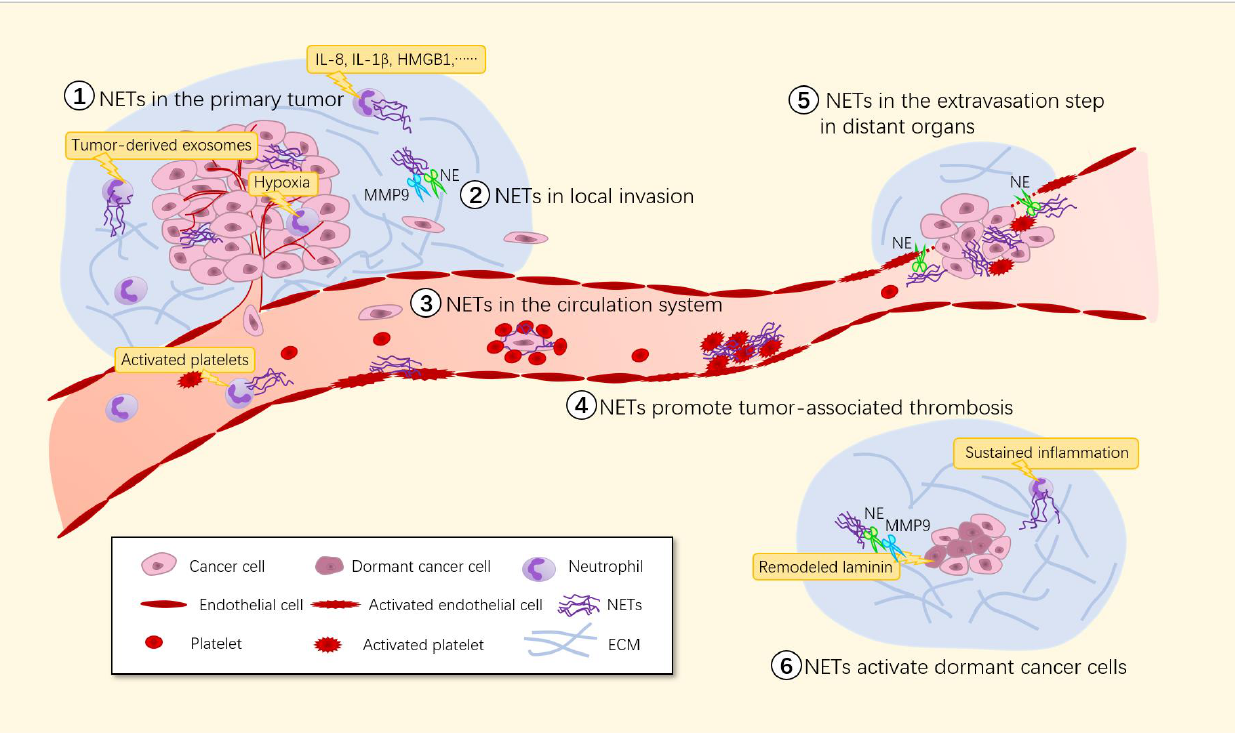
Figure 2. Involvement of NETs in tumor metastasis. Many stimuli including the hypoxic environment in growing solid tumors, inflammatory cytokines and activated platelets trigger NET formation in the tumor microenvironment. ① The existence of NETs promotes primary tumor growth through both the direct effect of NET components on the tumor cells themselves and the indirect effect of NETs on other components of the tumor microenvironment. ② Proteases in NETs can degrade the ECM, which subsequently release s cytokines to promote tumor cell growth and survival. ③ NETs can cover CTCs with platelets, creating a physical barrier between immune cells and CTCs that is difficult to penetrate. ④ Adhesion of massive NETs to the vasculature may initiate thrombosis by providing a scaffold for platelet adhesion, acti- vation and thrombin generation. ⑤ NETs capture tumor cells and bind them to vascular walls via von Willebrand factor (VWF), disrupting the normal connections between endothelial cells and increasing the permeability of blood vessels, making it easier for tumor cells to break through the vascular walls to reach distant organs and form micrometastases. ⑥ The NET-associated proteases NE and MMP- 9 can activate integrin α3β1 signaling by remodeling laminin, thus inducing the proliferation of dormant cancer cells.